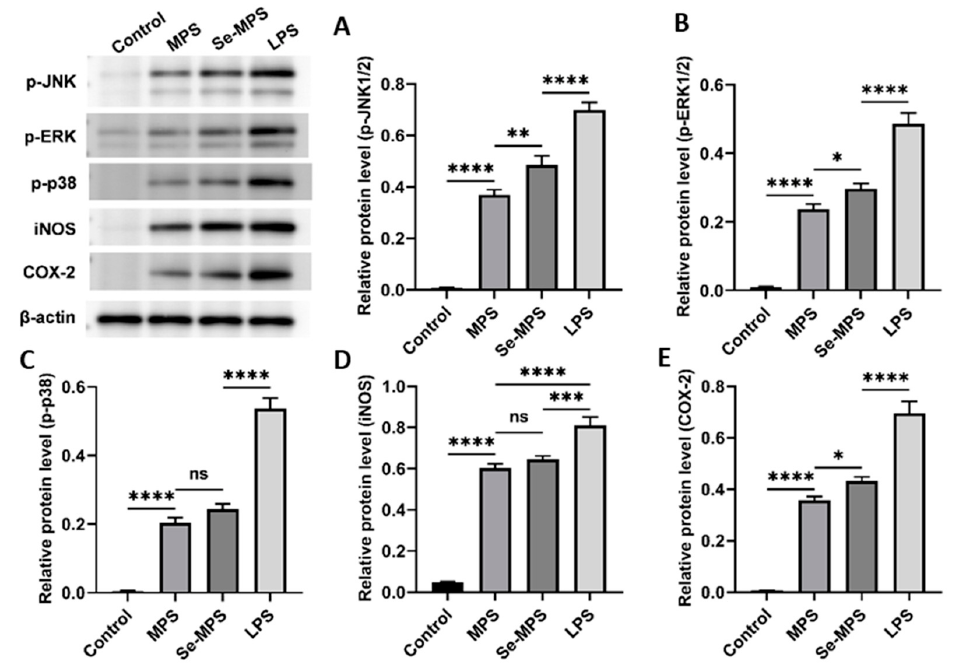
Figure 8. p-JNK ( A ), p-ERK ( B ), p-p38 ( C ), iNOS ( D ), and COX-2 ( E ) protein expression levels in RAW 264.7 cells treated with MPS and Se-MPS. *, p < 0.05; **, p < 0.01, ***, p < 0.001; ****, p < 0.0001; ns, not RAW 264.7 cells treated with MPS and Se-MPS. *, p < 0.05; **, p < 0.01; ***, p < 0.001; ****, p < 0.0001; ns, not significant; MPS— Morel polysaccharide; Se-MPS - Se-enriched Morel polysaccharide; LPS— lipopolysaccharide; p-JNK—phosphorylated c-Jun N-terminal kinase; p-ERK—phosphorylated extra- cellular signal-regulated kinase; p-p38—phosphorylated protein-38; iNOS—inducible nitric oxide synthase;